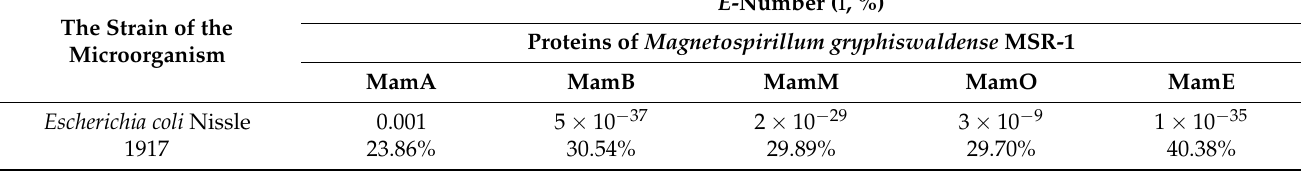
Table 1. Alignment of the proteins of the Mam group of M. gryphiswaldense MSR-1 and the proteome of the bacterium